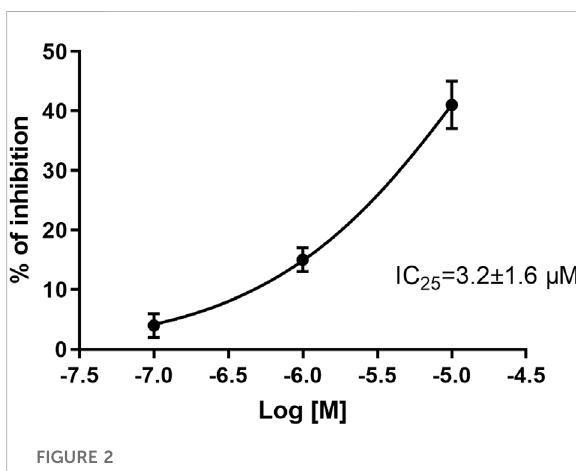
FIGURE 2 Effect of CPL500036 on inhibition of hERG tail